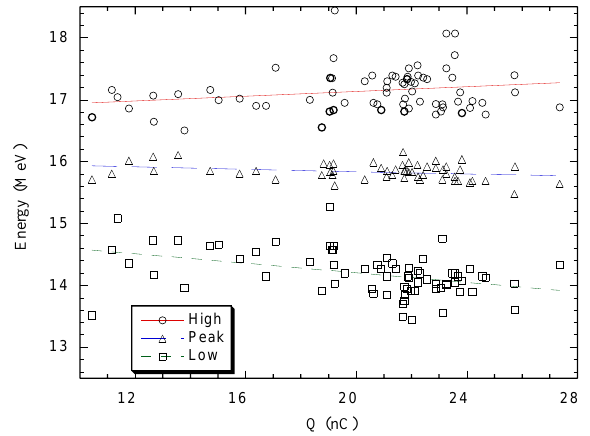
FIG. 10. Minimum, maximum, and peak intensity of mea- sured energy spectra, as a function of charge Q .